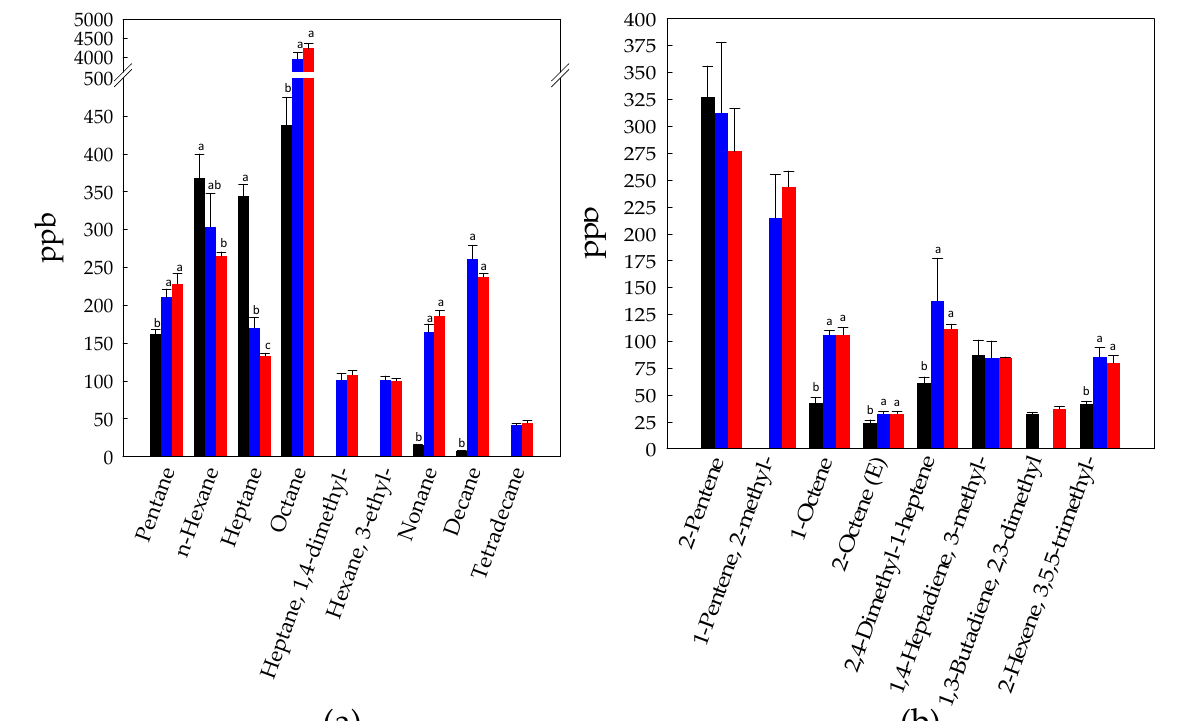
Figure 6. Concentration (ppb) of alkanes ( a ) and alkenes ( b ) identified in Raw- (black bars), Unstarted- (blue bars), and Started-BCP (red bars). Data are the means ( ± SD) of three independent experiments analyzed in triplicate. Data were subjected to one-way ANOVA; pair-comparisons of treatment means was achieved by Tukey’s procedure at p < 0.05. For each compound, bars with different superscript letters differ significantly ( p < 0.05).